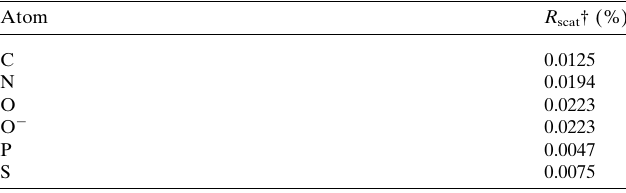
Table 1 R scat factors of X-ray scattering factors against the reference